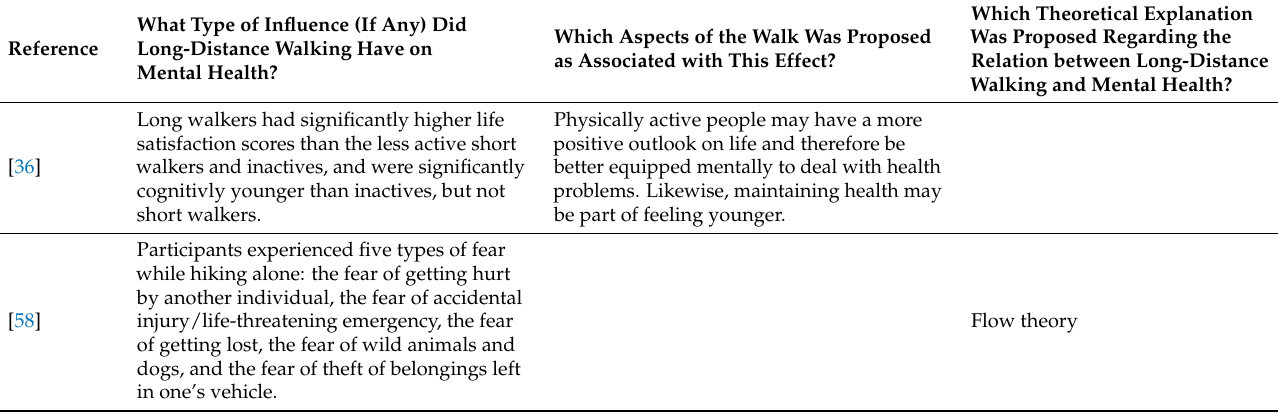
Table A2. Overview of the potential relation between long-distance walking and mental health.